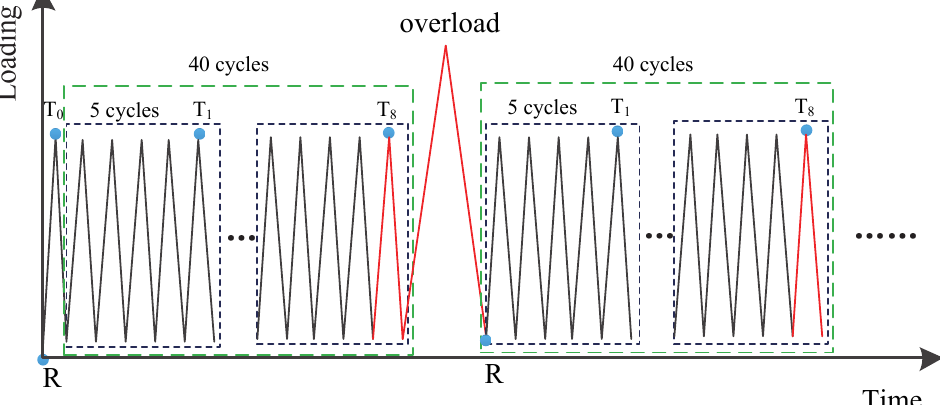
Figure 2: The loading scheme of the experiment (the 40 cycles before and after the overload cycle is a loading block contains 8 sub- block with 5 cycles for each of